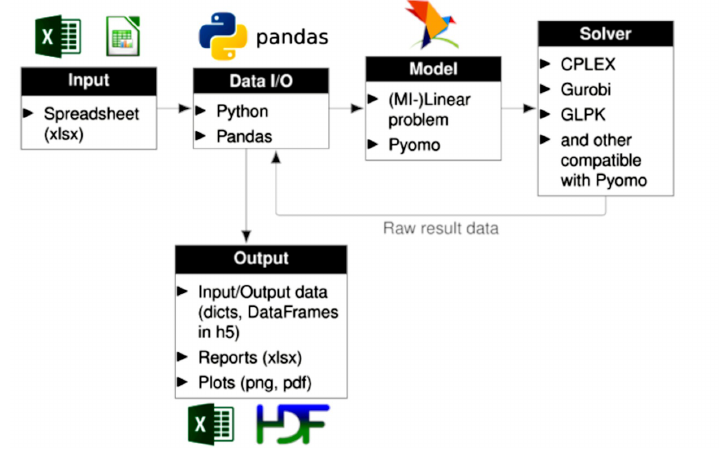
Figure 1. urbs toolchain